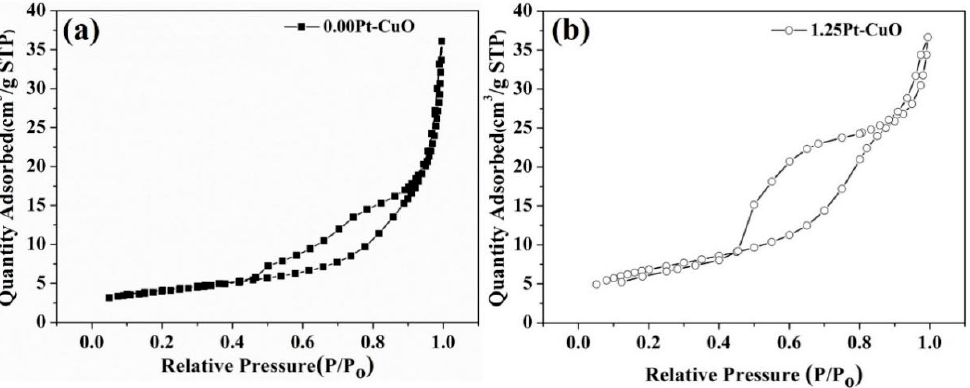
Figure 6. Typical N 2 adsorption-desorption isotherms of different specimens, as follows: ( a ) 0.00Pt-CuO and ( b ) 1.25Pt-CuO.